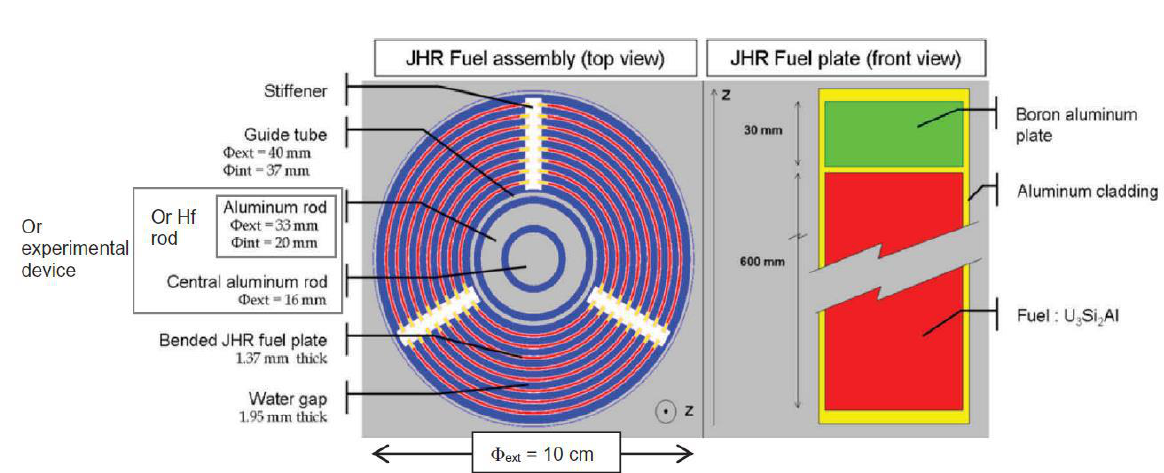
Figure 2. JHR fuel element and JHR Fuel Plate Description.